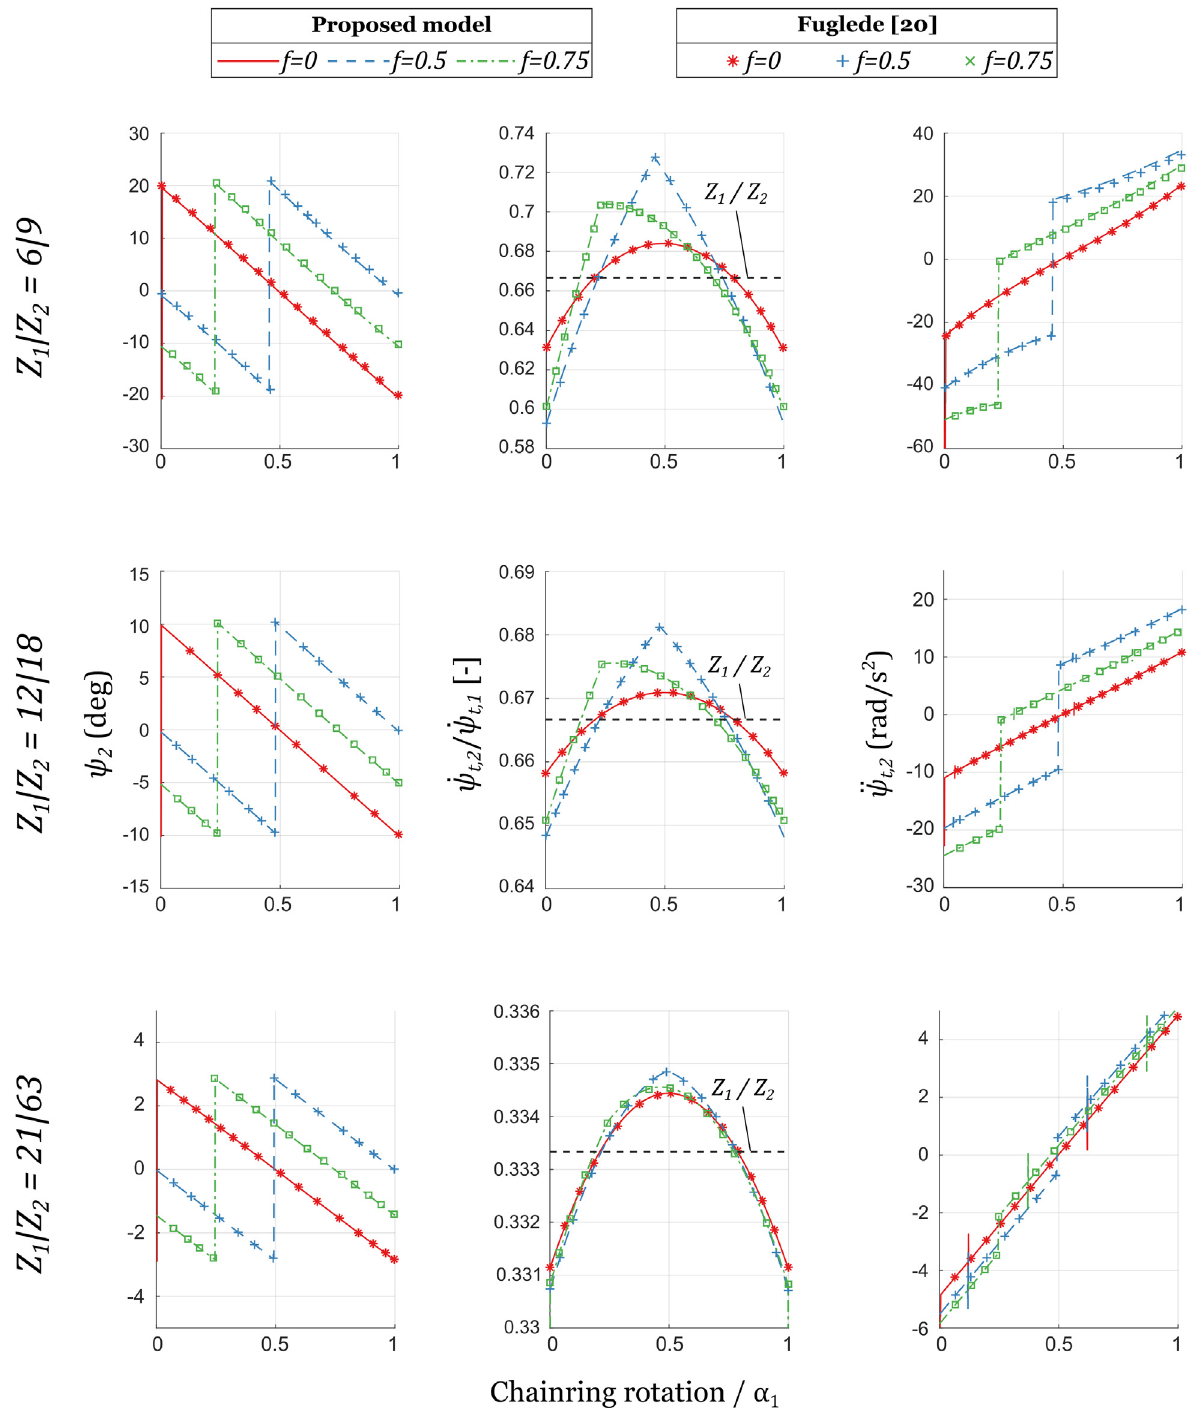
Fig. B1. Chain drive kinematics, comparison with Fuglede et al.